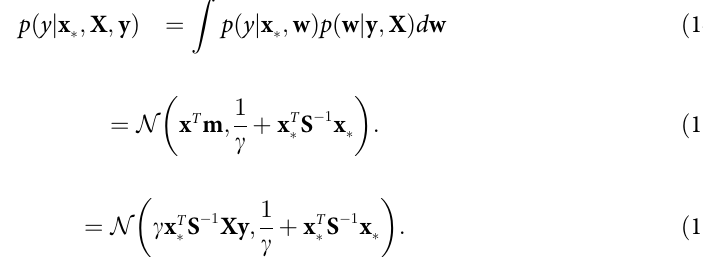
S1 Table. Common shorthand Metropolitan Statistical Area (MSA) name and the corre-